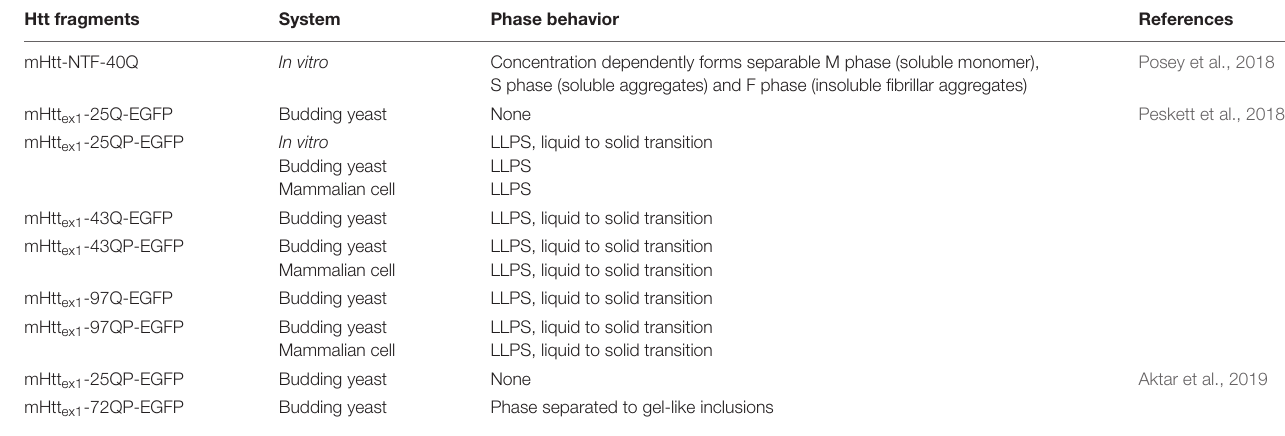
TABLE 1 | Summary of mHtt phase